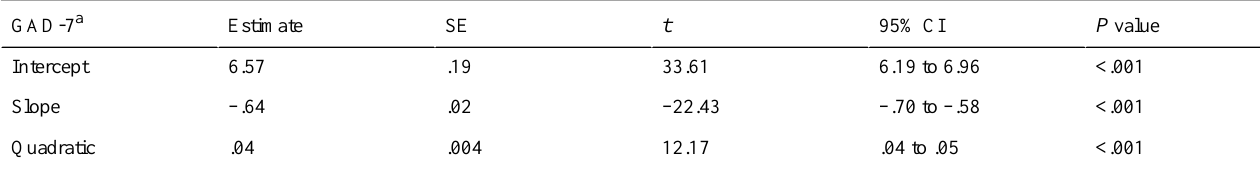
Table 2. Unconditional growth model for anxiety symptoms.